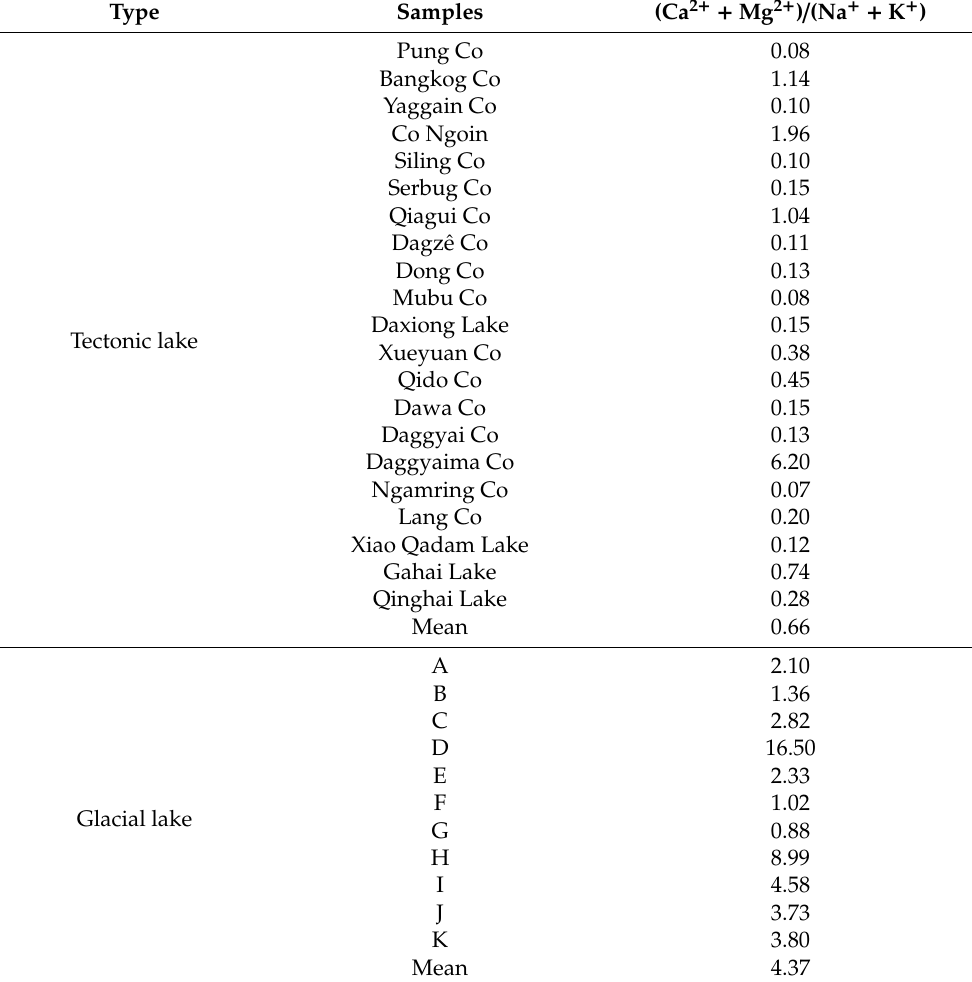
Table 5. The concentration ratio for (Ca 2 + + Mg 2 + ) / (Na + + K + ) of the tectonic lakes and the glacial lakes in Tibetan